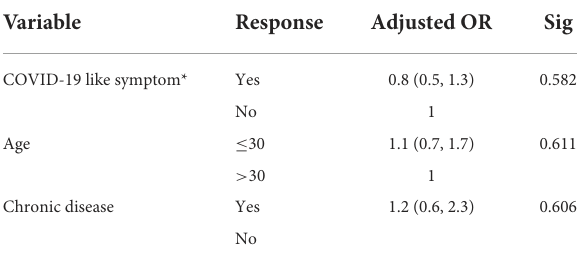
TABLE 13 Binary logistic regression model, the association between COVID-19 like symptom and local side effect among healthcare workers in Ethiopia, 2021.